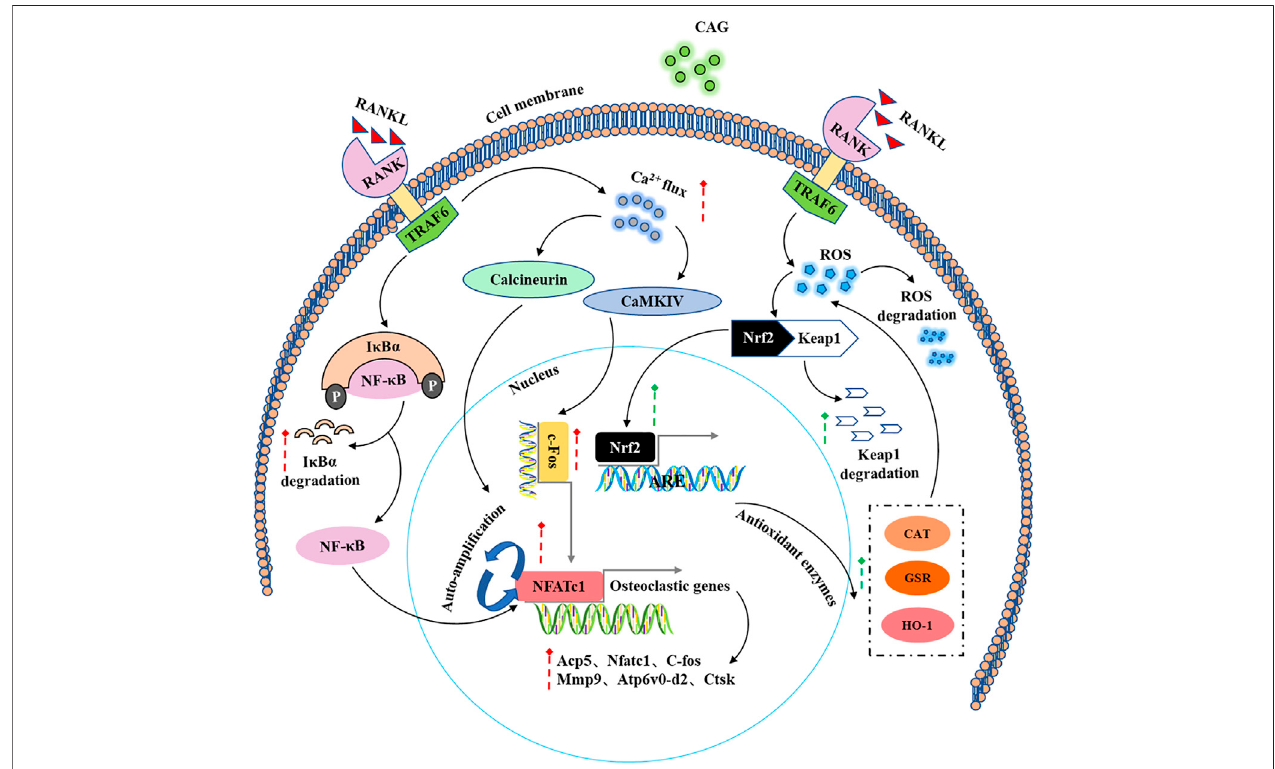
FIGURE 6 | A schematic diagram of the regulatory effect of CAG in the intracellular signaling pathways induced by RANKL.